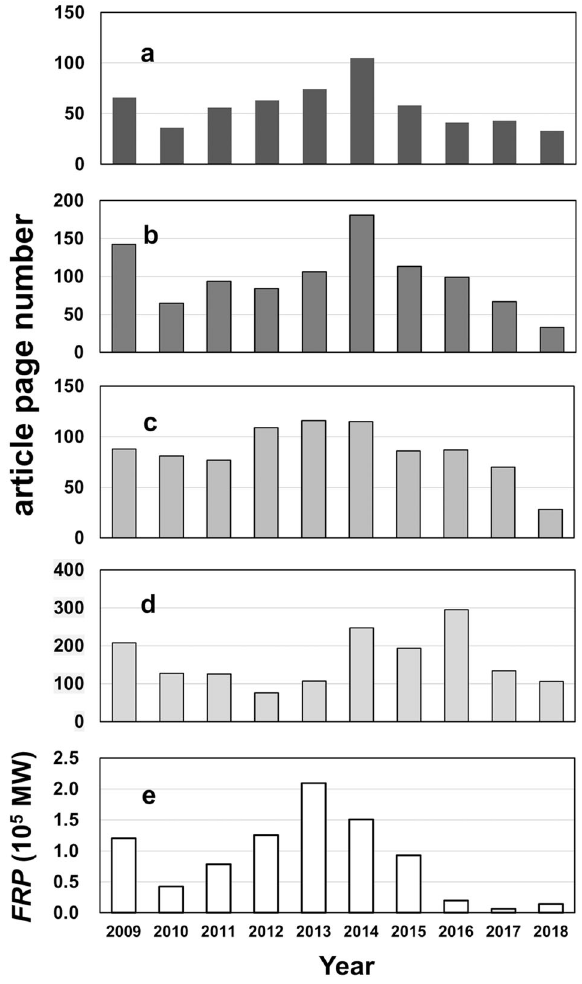
Fig. 2 Annual page numbers of articles relevant to search terms. a “ acute illness ” , b “ smoke damage ” , c “ air pollution ” , and d “ peatland fi re ” . e annual Fire Radiation Power ( FRP ) around Pekanbaru within a radius of 100